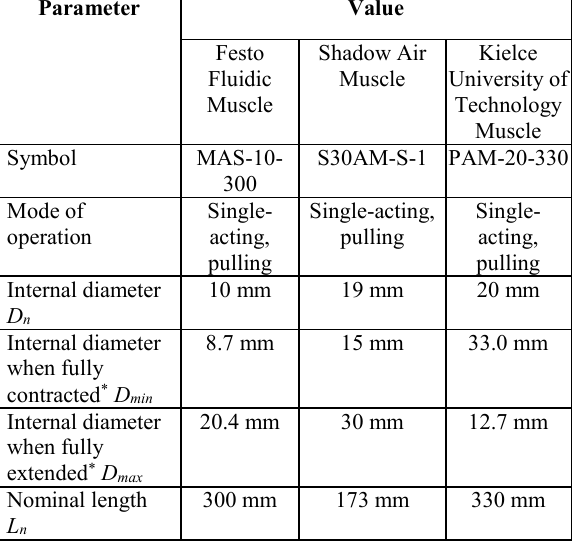
Table 1. Technical parameters of the pneumatic artificial